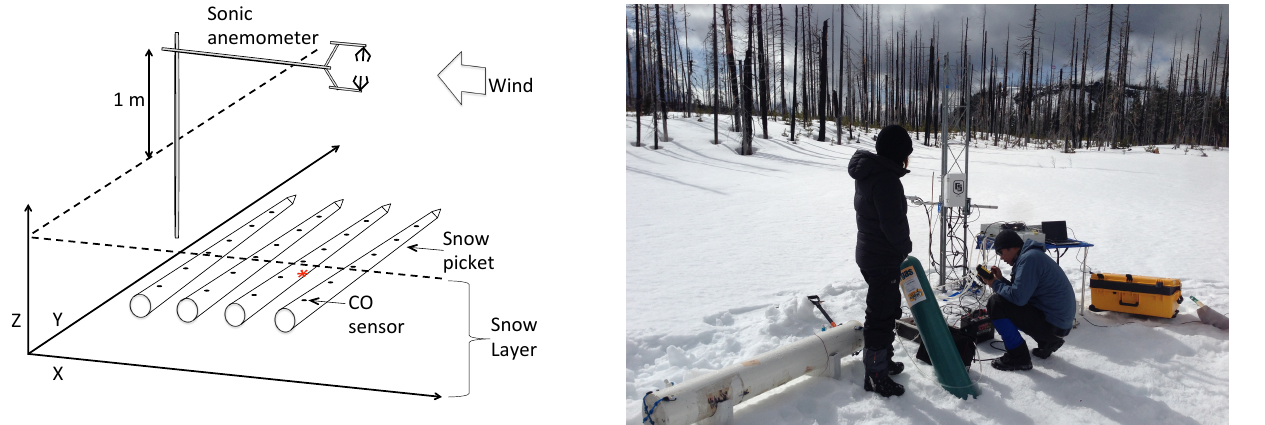
Figure 2. Diagram of the experimental setup showing relative po- sitions of the sonic anemometer and snow pickets. The red asterisk marks the release point on the bottom of one of the snow pickets. The CO sensors on four snow pickets define an x – y plane that is retained in subsequent figures.